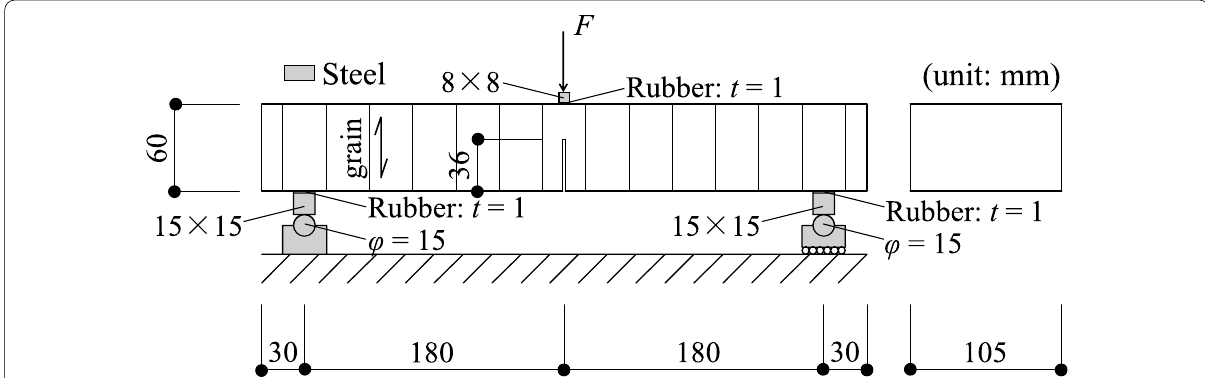
Fig. 6 Schematic diagram of the single-edge-notched bending